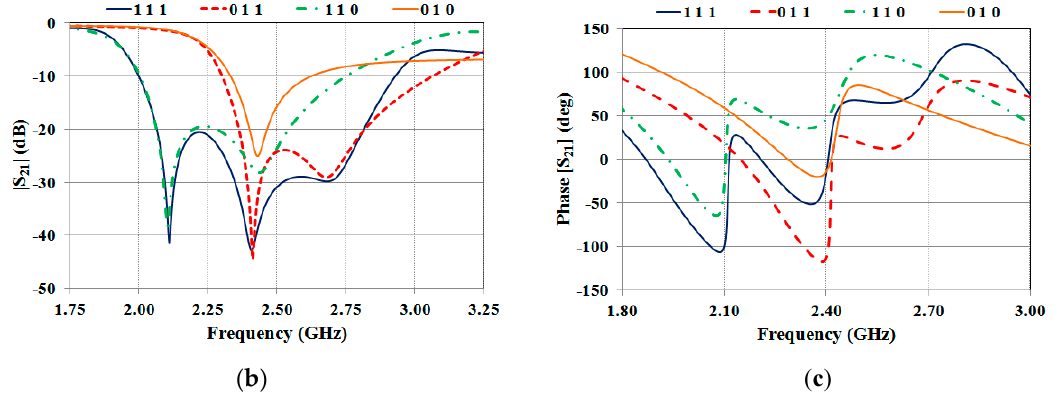
Figure 4. Numerical results achieved for different multi-resonator structures: ( a ) amplitude of the S 21 achieved for multi-stopband structures with 3, 4, and 5 bits; amplitude ( b ) and phase ( c ) of the S 21 calculated from full-wave simulations for different configurations of a 3-bit structure.